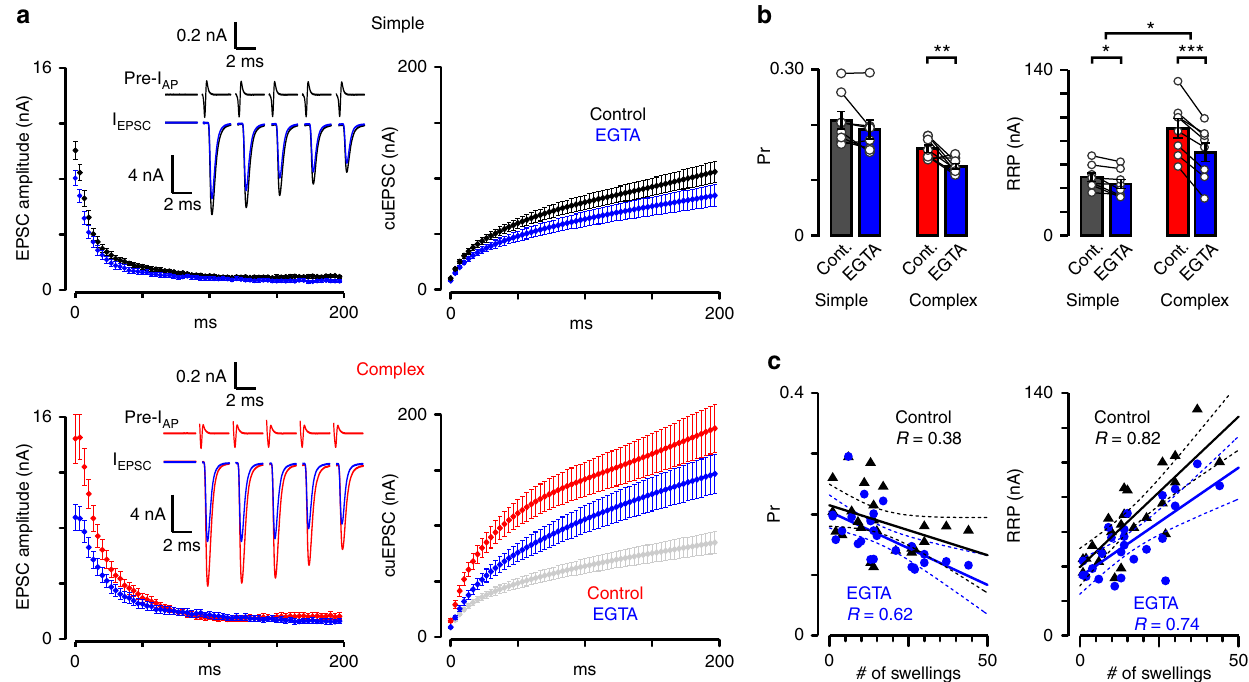
Fig. 6 EGTA sensitivity of the Pr and size of RRP is heterogeneous in mature calyces. a Average traces (mean ± SEM) show amplitudes (left panels) and cumulative amplitudes (cuEPSC, right panels) of action potential (AP) train-evoked EPSCs (300 Hz, 200 ms) in simple (black, upper) and complex (red, lower) calyces before and after EGTA loading (blue, 10 mM, 3 – 5 min). Insets: representative pre-I AP 1 – 5 (presynaptic compound AP currents) and EPSC1 – 5. Gray trace (last panel): cuEPSC of simple calyces after EGTA injection for comparison (mean ± SEM). b Bar graphs show release probability (Pr) and readily releasable pool (RRP) before and after EGTA loading. (Pr, simple, control, 0.208 ± 0.016, EGTA, 0.191 ± 0.017, n = 8/7, t = 2.211, p = 0.0627, df = 7, paired t -test [p.t.t.]; complex, control, 0.157 ± 0.007, EGTA, 0.125 ± 0.005, n = 8/8, t = 3.53, p = 0.0096, df = 7, p.t.t.; RRP, simple, control, 49.32 ± 3.56 nA, EGTA, 43.56 ± 3.904 nA, n = 8/7, t = 3.412, p = 0.0113, df = 7, p.t.t.; complex, control, 90.64 ± 8.13 nA, EGTA, 70.32 ± 7.97 nA, n = 8/8, t = 9.363, p < 0.0001, df = 7, p.t.t.). The difference in EGTA effect on simple and complex calyces was quanti fi ed as EGTA/control (Pr, simple, 0.917 ± 0.035, n = 8/7, complex, 0.813 ± 0.052, n = 8/8, t = 1.664, p = 0.118, df = 14, unpaired t -test [u.t.t.]; RRP, simple, 0.881 ± 0.037, n = 8/7, complex, 0.762 ± 0.036, n = 8/8, t = 2.305, p = 0.037, df = 14, u.t.t.). c Pr and RRP size for all EGTA loaded synapses were plotted against the number of swellings (black triangles, control; blue dots, EGTA) and linearly fi tted (mean ± 95% con fi dence interval). The y -intercept of the RRP fi t gives RRP size in stalk (39.30 ± 10.08 nA), the slope determines RRP per swelling (1.74 ± 0.55 nA). R demonstrates correlation strength. Bar graphs summarize mean ± SEM (* p < 0.05, ** p < 0.01, *** p < 0.001). See Supplementary Figure